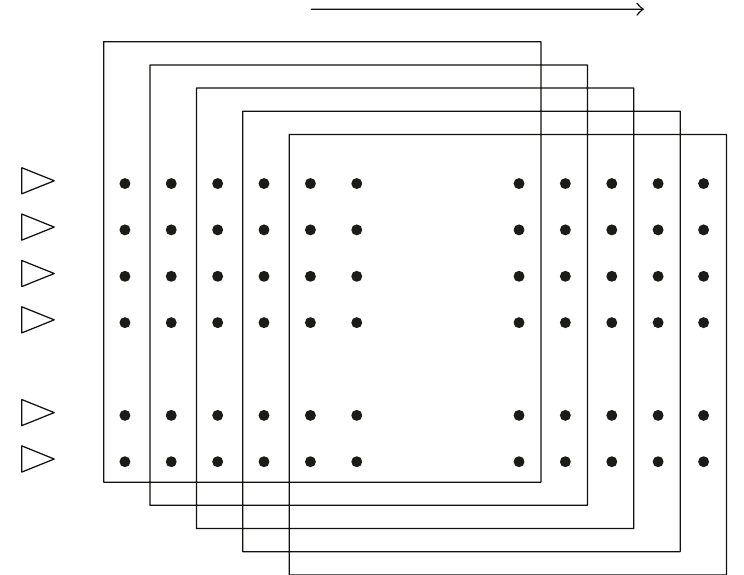
Figure 1: Data stacking technique ( K =